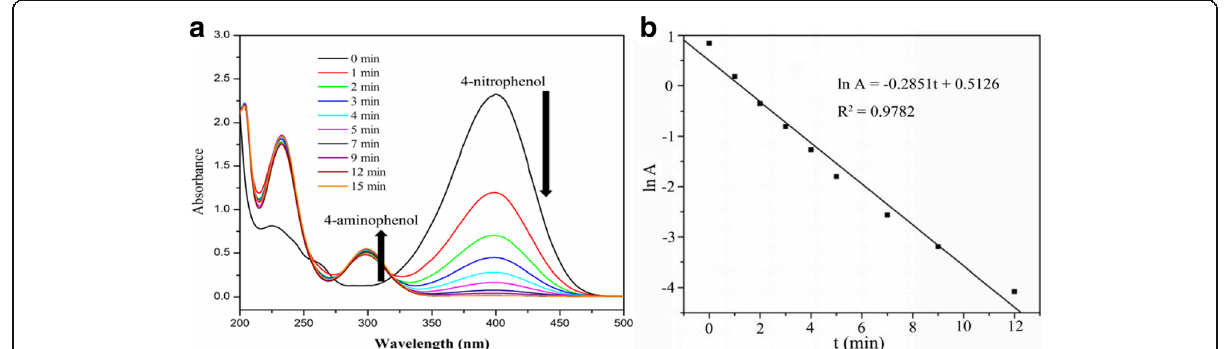
Fig. 5 a The time-dependent UV-vis absorption spectrum and b plot of lnA versus time for the reduction of 4-NP to 4-AP in the presence of Ag@HPS-1 catalyst